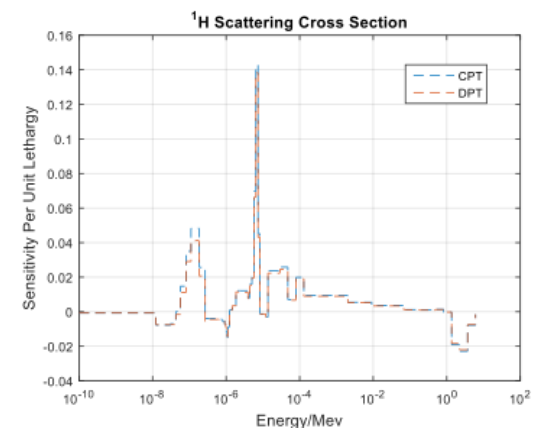
Figure 3. The sensitivity per unit lethargy of k to the 1 H scatter- ing cross sections